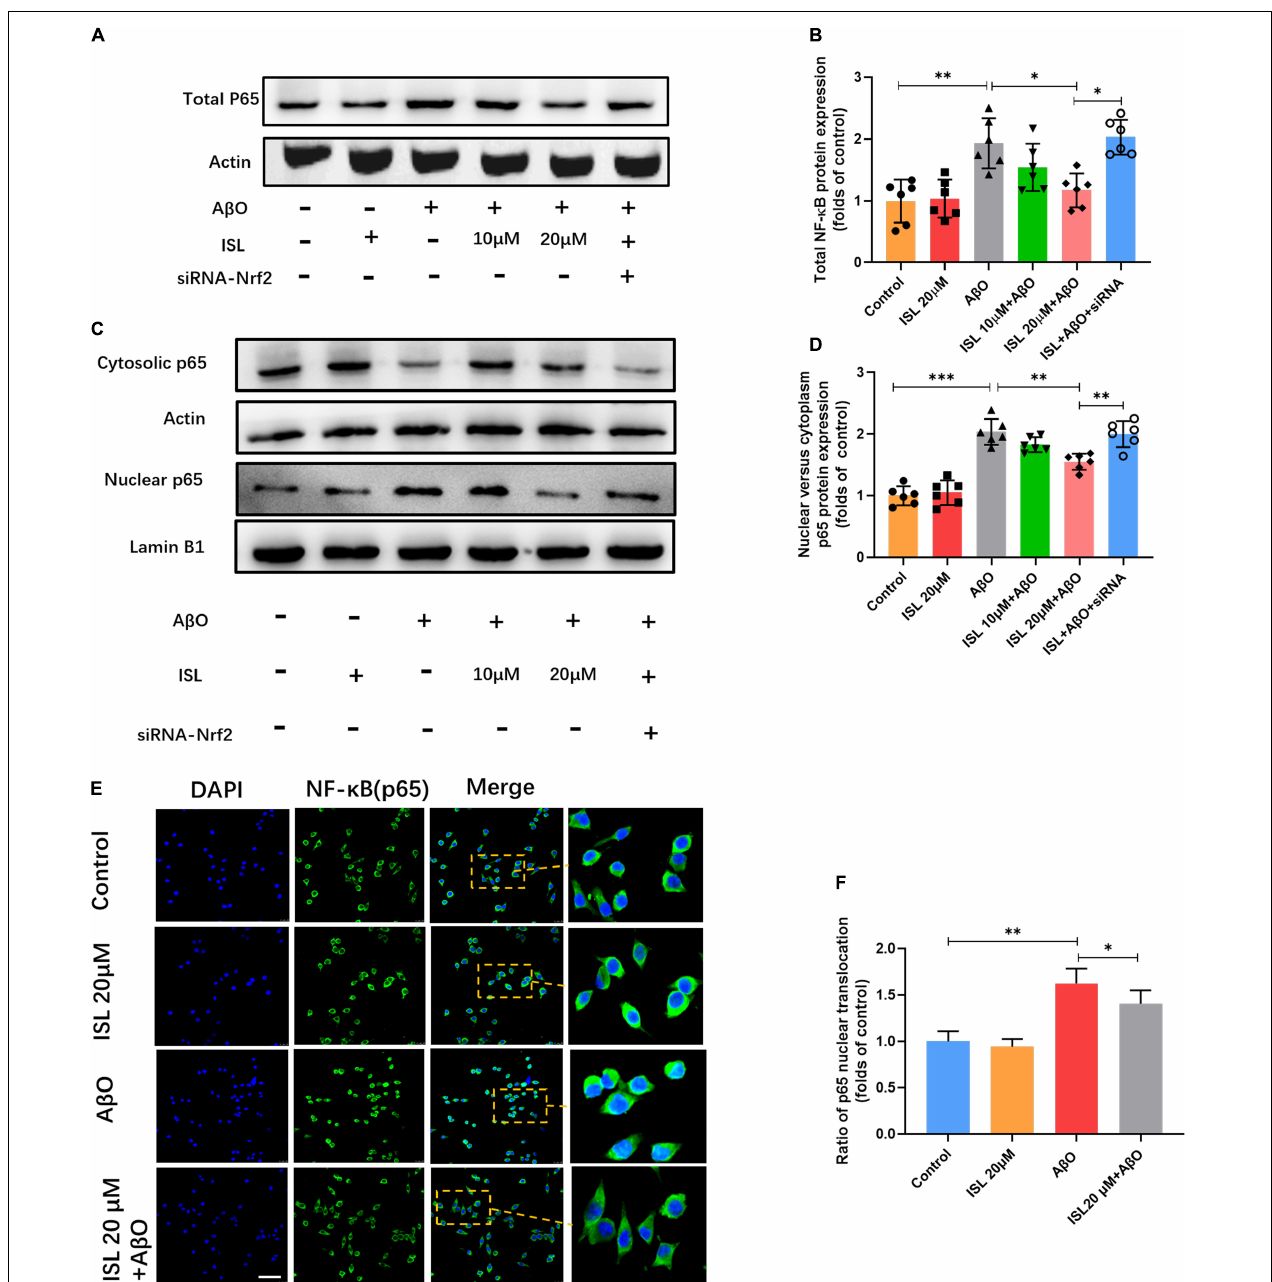
FIGURE 8 | ISL attenuates A β O induced activation of the NF- κ B pathway in BV2 cells. (A–D) BV2 cells, including those transfected by Nrf2 siRNA, were pre-treated with ISL for 2 h and then co-treated with 5 µ M A β O for 1 h. Protein expression of total, cytosolic and nuclear NF- κ B were analyzed by Western blot. (E,F) BV2 cells, including those transfected by Nrf2 siRNA, were pre-treated with ISL for 2 h and then co-treated with 5 µ M A β O for 24 h. The translocation of NF- κ Bp65 (green) to the nucleus (blue) is shown by confocal microscopic images. Scale bar: 50 µ m. ∗ p < 0.05, ∗∗ p < 0.01, ∗ ∗ ∗ p < 0.001. n = 6 per